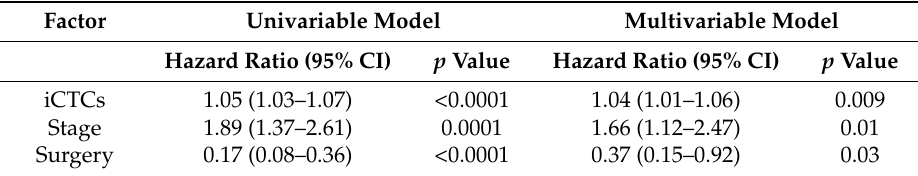
Table 4. Hazard ratio (HR) for stage and